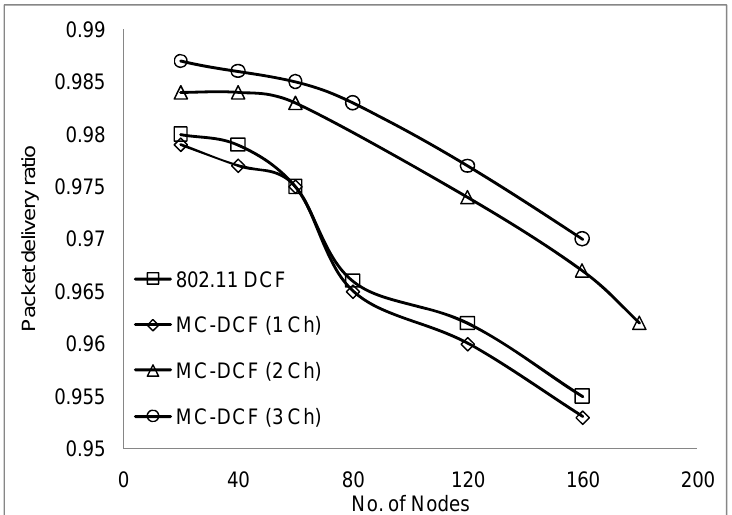
Figure 13. Delivery ratio impact on node